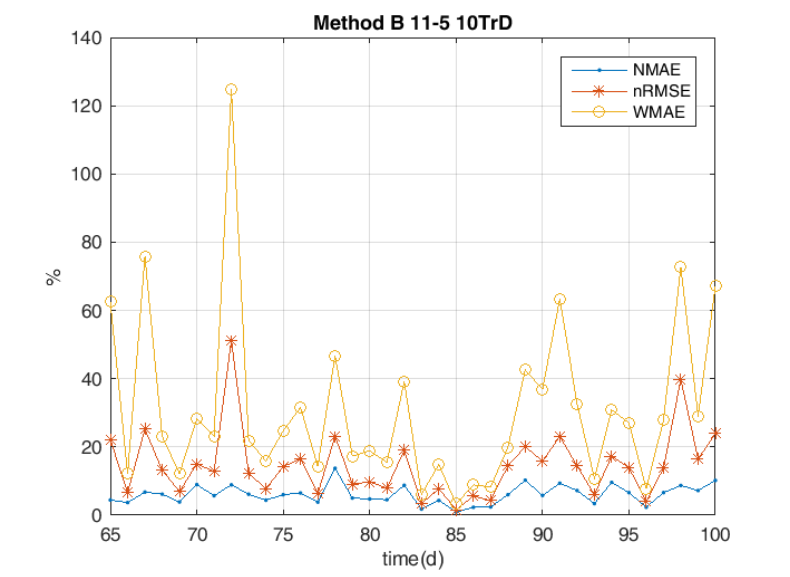
Figure 7. Example of the daily errors trend. NMAE : normalized mean absolute error; nRMSE : normalized root mean square error; WMAE : weighted mean absolute error.